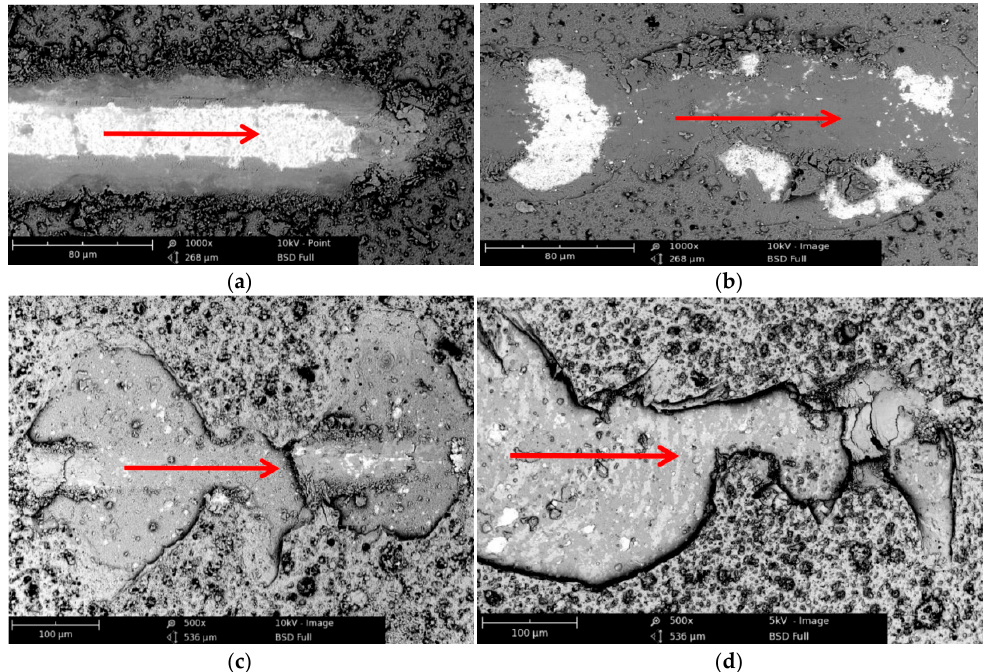
Figure 14. Wear pattern on coatings in scratch testing: ( a ) S2, ( b ) S4, ( c ) S6, and ( d )